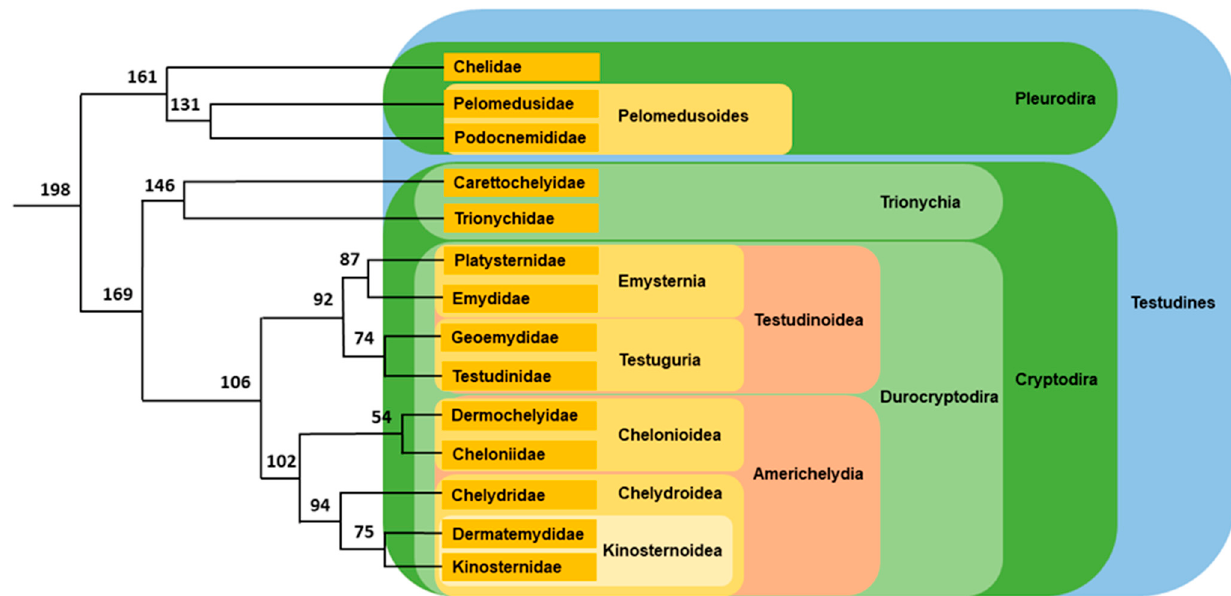
Figure 3. Phylogenic tree of turtle families. Relative positions of each turtle family and superior clade are represented. Branch lengths are not proportional to time. Numbers indicate divergence time (Myrs) from present for nodes, according to [39]. Colors indicate the different level of clades in the phylogenetic tree from the fourteen families (golden yellow) to the order (blue).